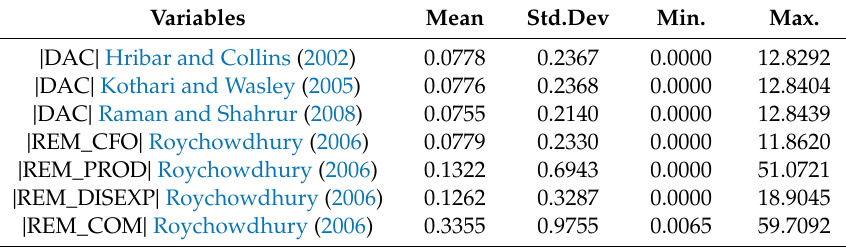
Table 2. Descriptive Statistics for the Dependent variables (AEM and REM measures).